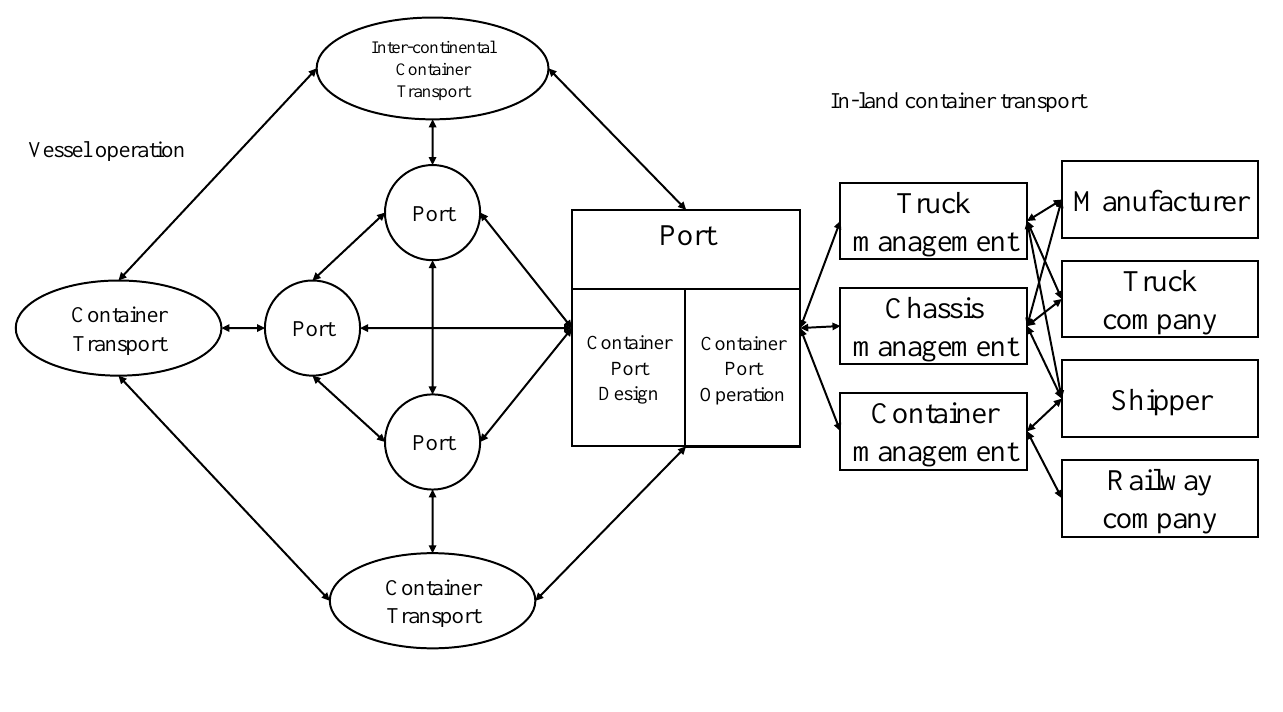
Figure 5. Summary of research in MSC